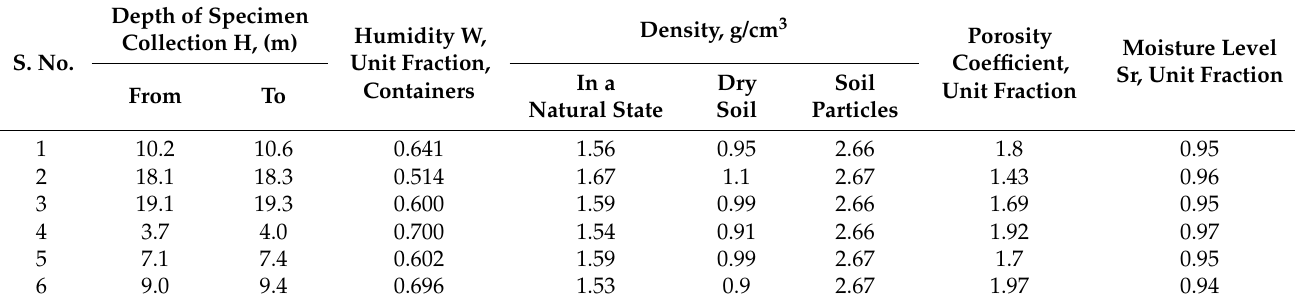
Table 1. Physical properties of the investigated cement-stabilized soils.